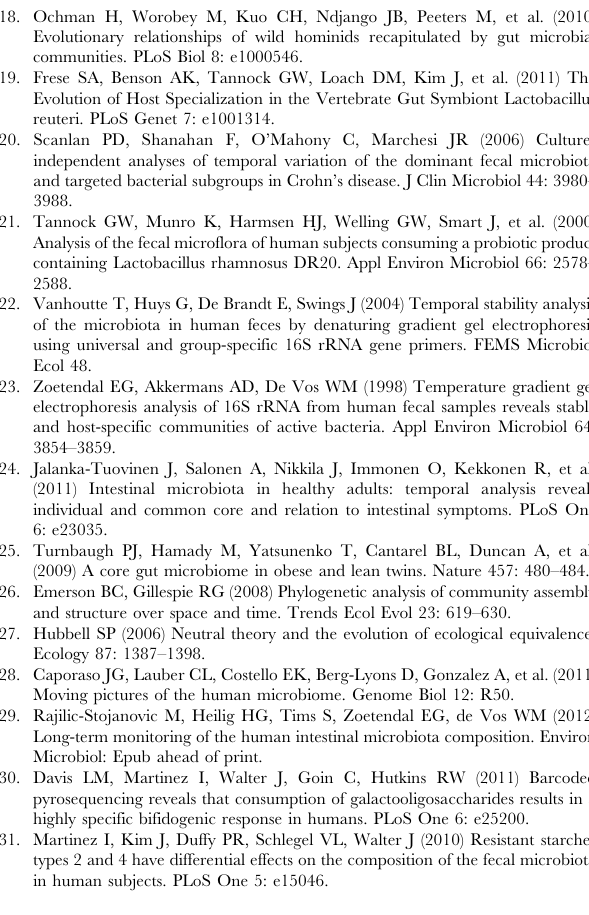
of the samples) within subjects are presented in their phylogenetic context. Phylogenetic trees were constructed as described in Suppl. Fig. 4. (PDF) Figure S8 Invasion and extinction events within the fecal bacterial community. The abundance of OTUs that displayed temporal dynamics that suggested events of invasion or extinction are shown. See text for details. (PDF) Figure S9 Characterization of the fecal microbiota of triple-associated gnotobiotic mice. Genus level classification (Classifer, RDP) of sequences obtained for each fecal sample of mice colonized by with Bifidobacterium adolescentis BD-1, Escherichia coli MG1655, and Bacteroides thetaiotaomicron VPI-5482 (A). Accu- mulated fraction of OTUs of total OTUs (blue line) and total sequences (red line) shared across all nine samples (B). The expected fraction and abundance represented by the broken black graph.